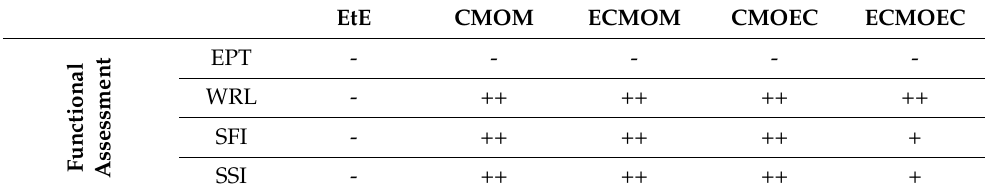
Table 1. Qualitative general classification of the performance of the therapeutic groups in the tests and essays carried out in vivo. The groups were classified according to the statistical differences